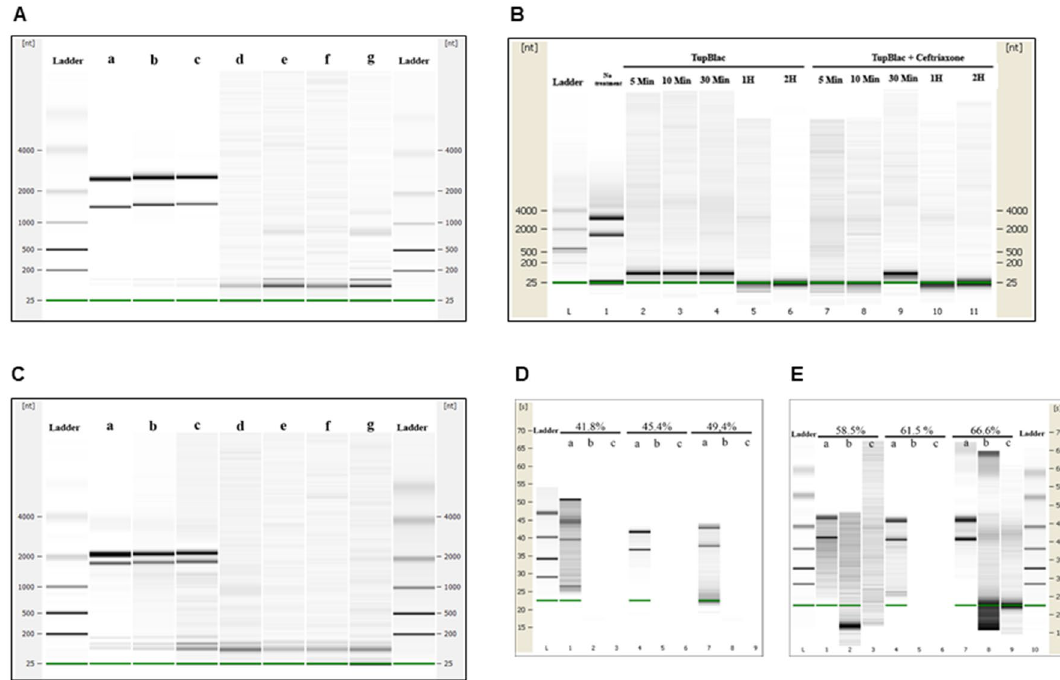
Figure 5. Digital gel images of RNase activity of expressed Tupanvirus protein TupBlac on RNAs originating from E. coli, Acanthamoeba castellanii , and bacteria that differ by the G + C-content of their genome. RNA samples (1 µg) were incubated with 15 µg of TupBlac at 30 °C in the absence or presence of 10 µg/mL of sulbactam or 200 µM of ceftriaxone. Nuclease activity was visualized as digital gel images performed using